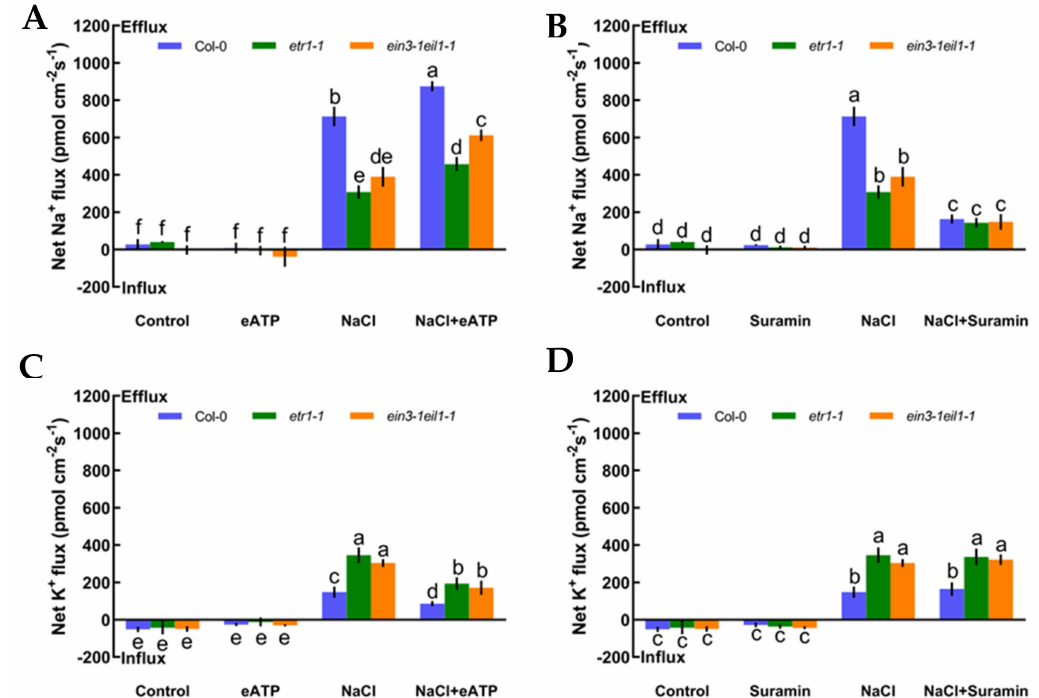
Figure 5. E ff ects of extracellular ATP (eATP, 300 µ M) and suramin (300 µ M) on the steady-state Na +